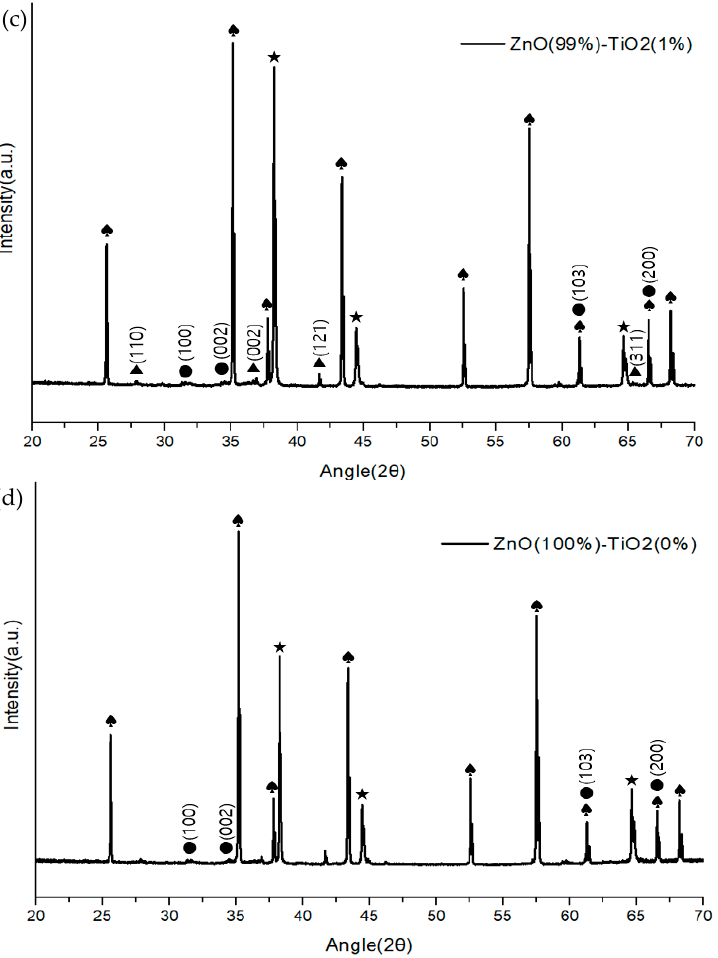
Figure 6. XRD analysis of ZnO-TiO 2 gas sensor ( ♠ : Al 2 O 3 ★ : Au ● : ZnO ▲ : TiO 2 ). ( a ) ZnO(90%)- TiO 2 (10%) ( b ) ZnO(95%)-TiO 2 (5%) ( c ) ZnO(99%)-TiO 2 (1%) ( d ) ZnO(100%)-TiO 2 (0%).